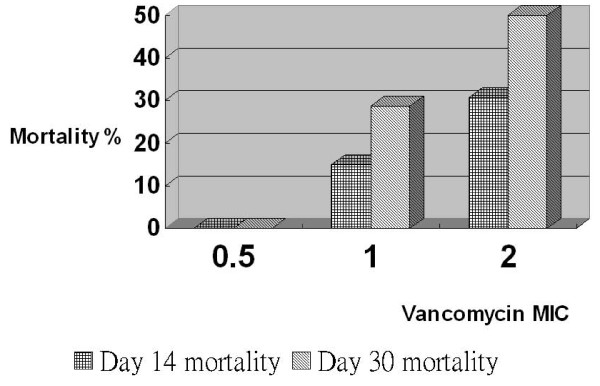
Mortality in different vancomycin MIC group. The relationship between vancomycin MIC and 14- and 30-days mortality